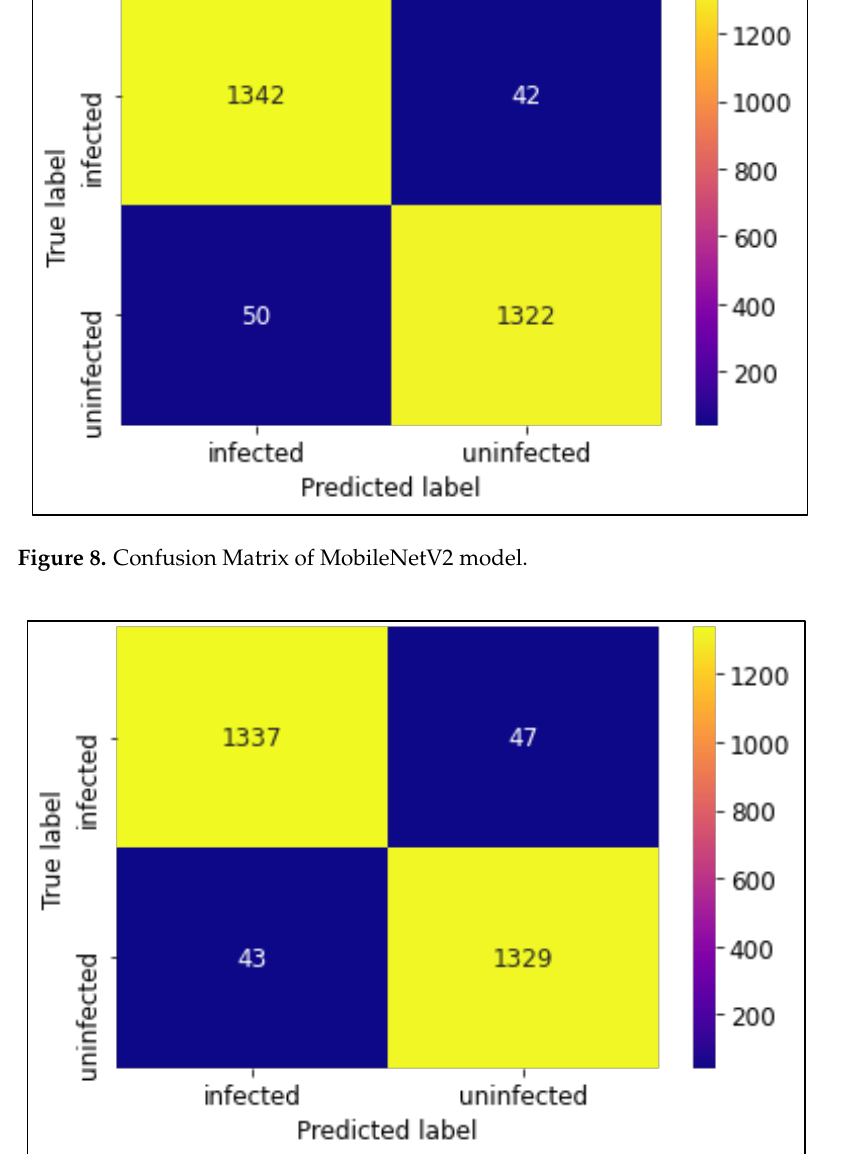
Figure 9. Confusion Matrix of ResNet50 model.